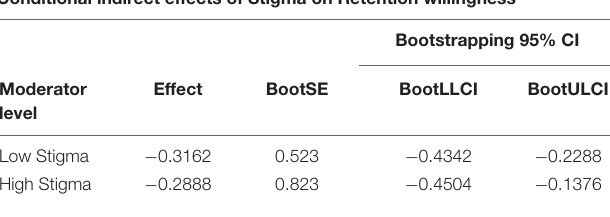
TABLE 10 | Test of moderated mediation effects (conditional indirect